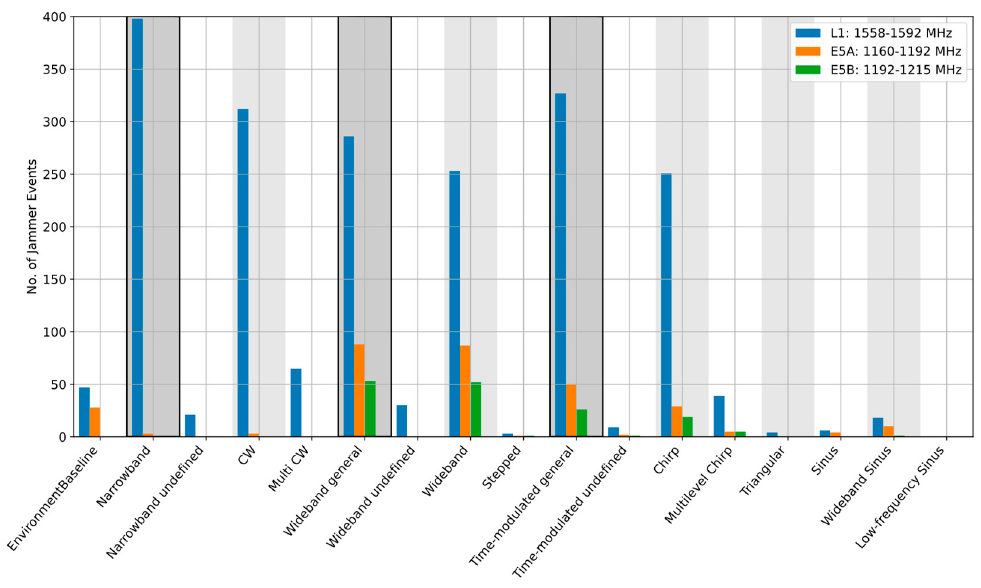
Figure 5. Detailed classification results, Moss station, Norway, 2021.